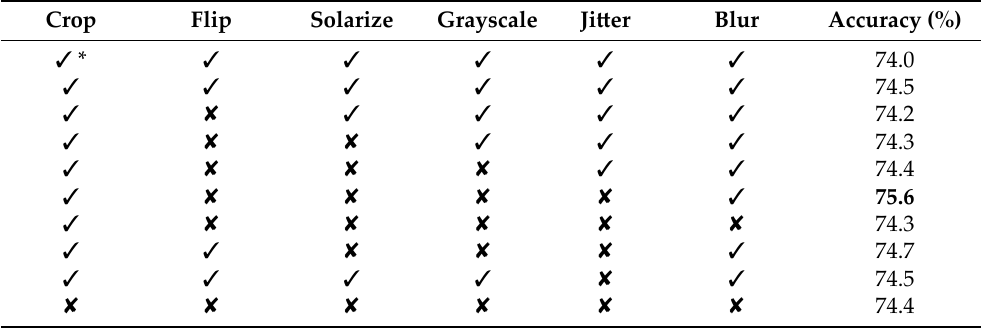
Table 5. Ablations on adding random data augmentations in our AV‑BT. The best result is in bold. Note that * denotes that the crop scale is adjusted to be relatively smaller. The original intention for this was to prevent cropping out the entire sounding target, resulting in breaking the agreed rule of an AVE, i.e., visible and audible at the same time.